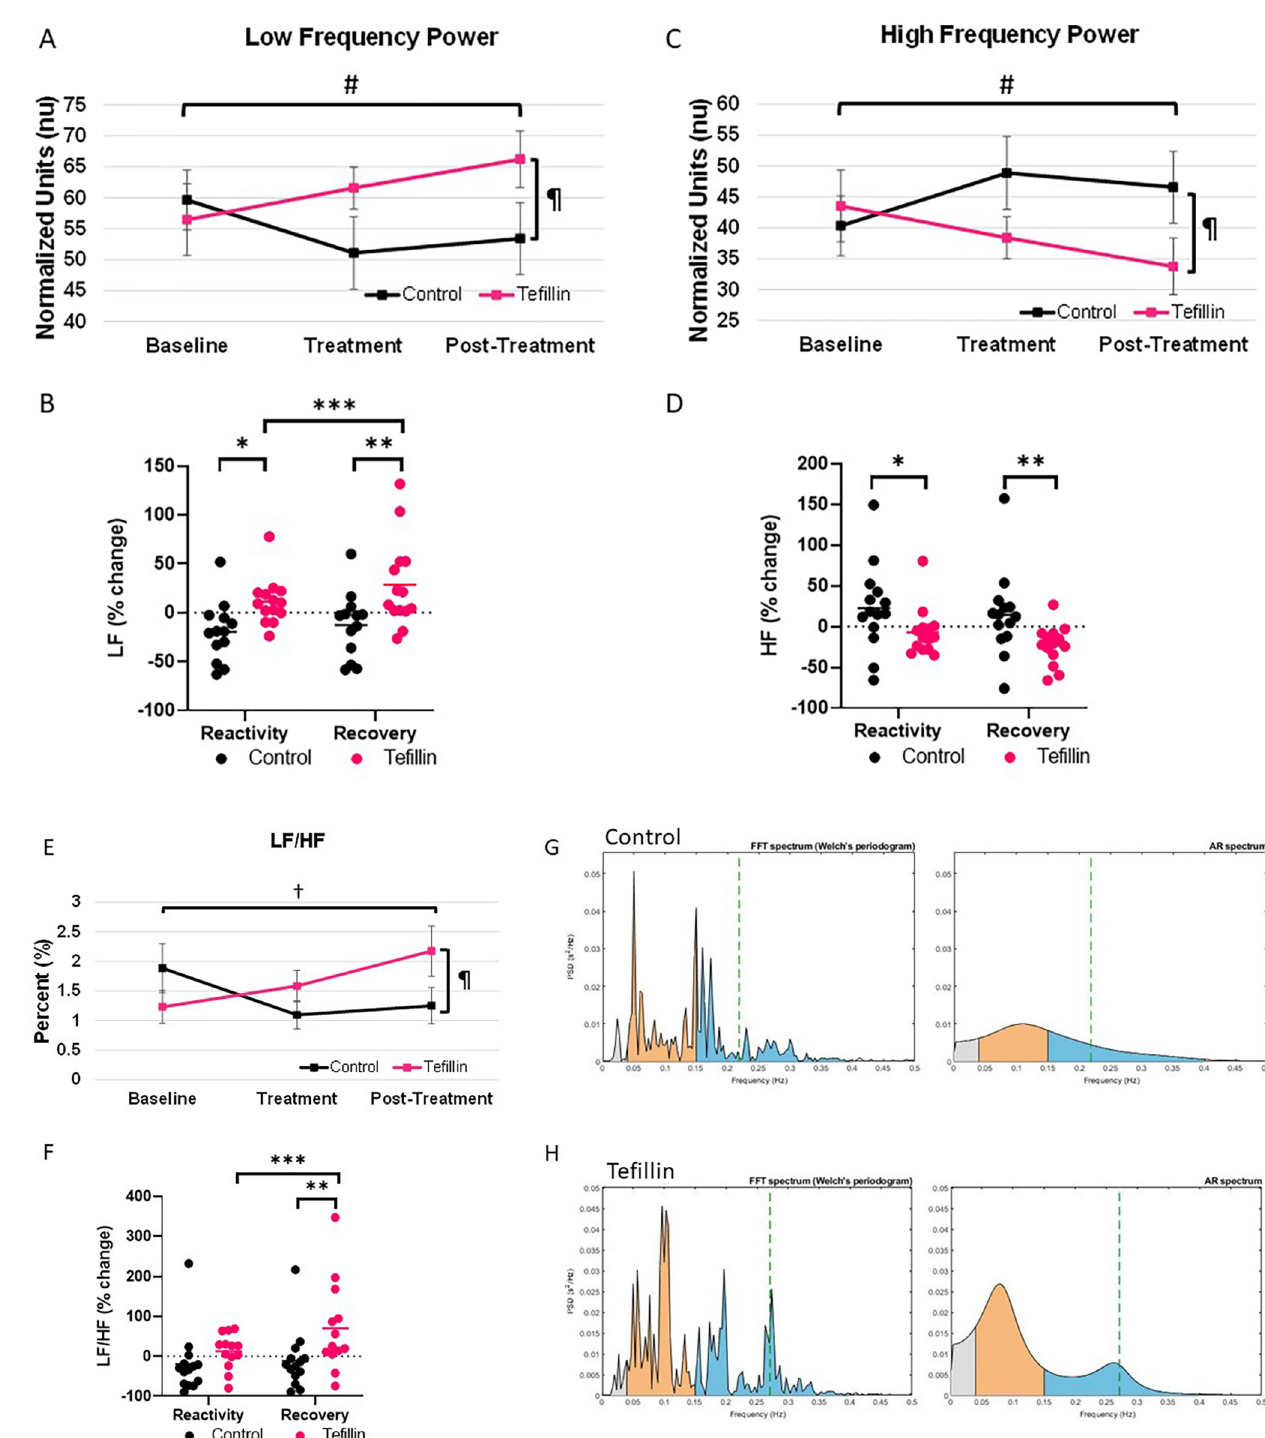
Fig 3. The frequency domain measurements were determined for control and tefillin subjects. Low frequencies (LF) for A . absolute values and B . percent change. High frequencies (HF) for C . absolute values and D . percent change. The ratio of LF/HF for E . absolute values and F . percent change. Absolute data represents an average of subjects during baseline, treatment and post-treatment ± SEM. Reactivity and recovery are the average differences between the baseline and treatment and treatment and post-treatment ± SEM, respectively. #P = 0.097 for tefillin baseline compared to tefillin post-treatment; ¶P = 0.087 for control compared to tefillin at post-treatment; � P < 0.05 for control versus tefillin at reactivity; �� P < 0.05 for control versus tefillin at recovery; and ��� P < 0.05 for tefillin